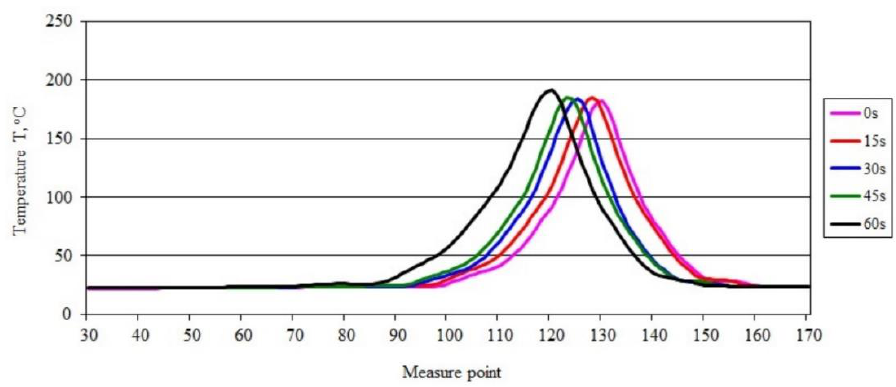
Figure 2. Temperature along the burning PE sample recorded in area 2.